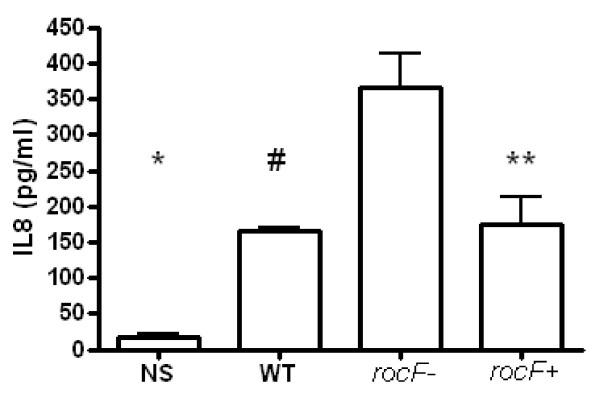
TherocFmutant ofH. pyloriinduces more IL-8 in AGS cells compared with wild typeH. pylori,as determined byELISAanalysis. Please see legend on Figure 4 for IL-8. One-way ANOVA p = 0.0002; *p = 0.0003 (rocF- vs NS); #p = 0.045 (rocF- vs WT); **p = 0.0185 (rocF- vs rocF+). Values represent the average signal ± SEM of four independent replicates.